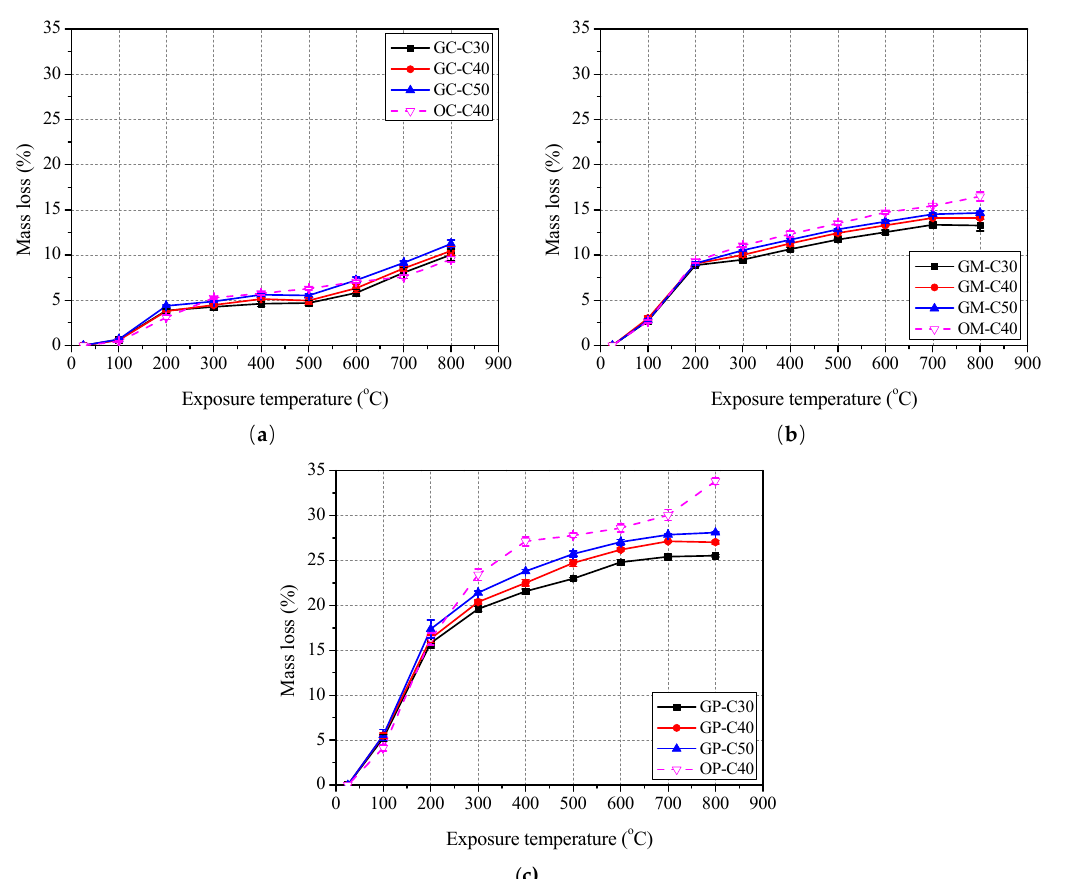
Figure 5. Change of surface morphology of geopolymer and ordinary concrete, mortar and paste (all specimens with grade of C40).